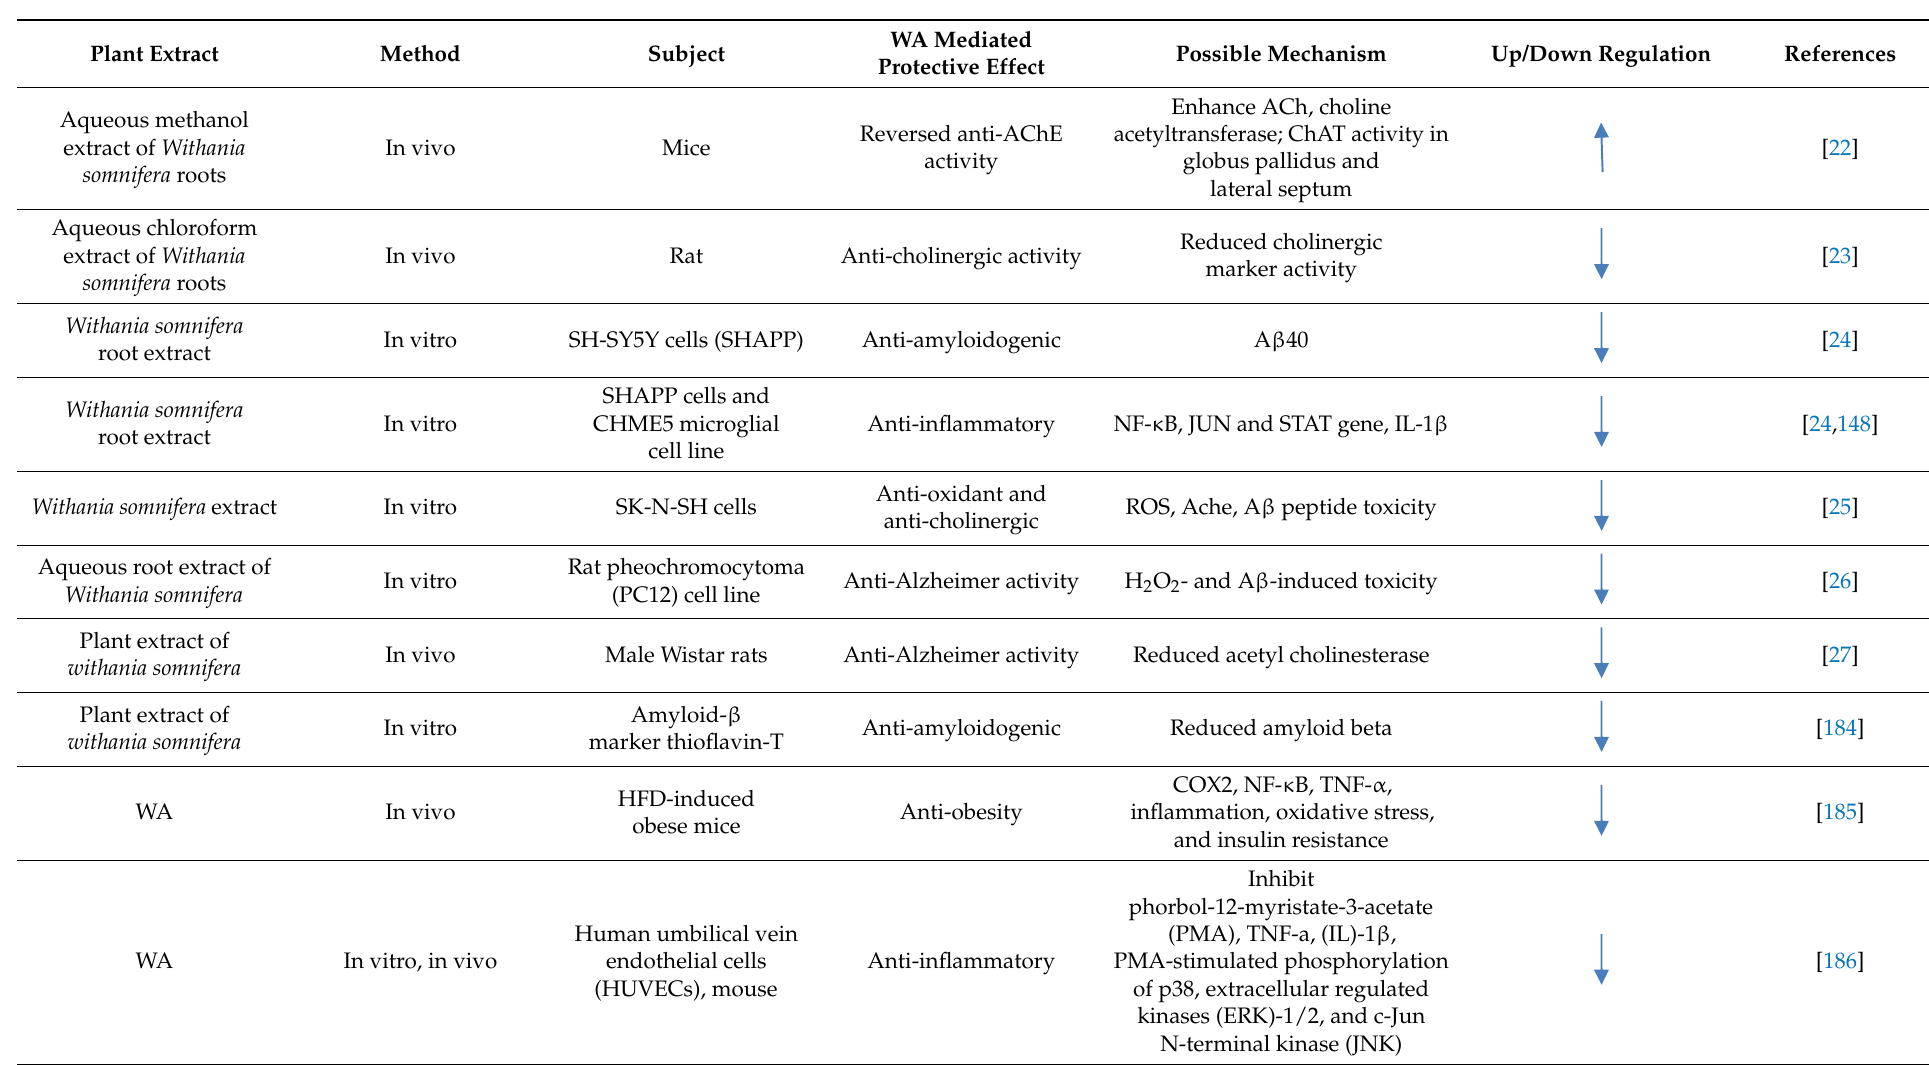
Table 1. Preclinical trials of